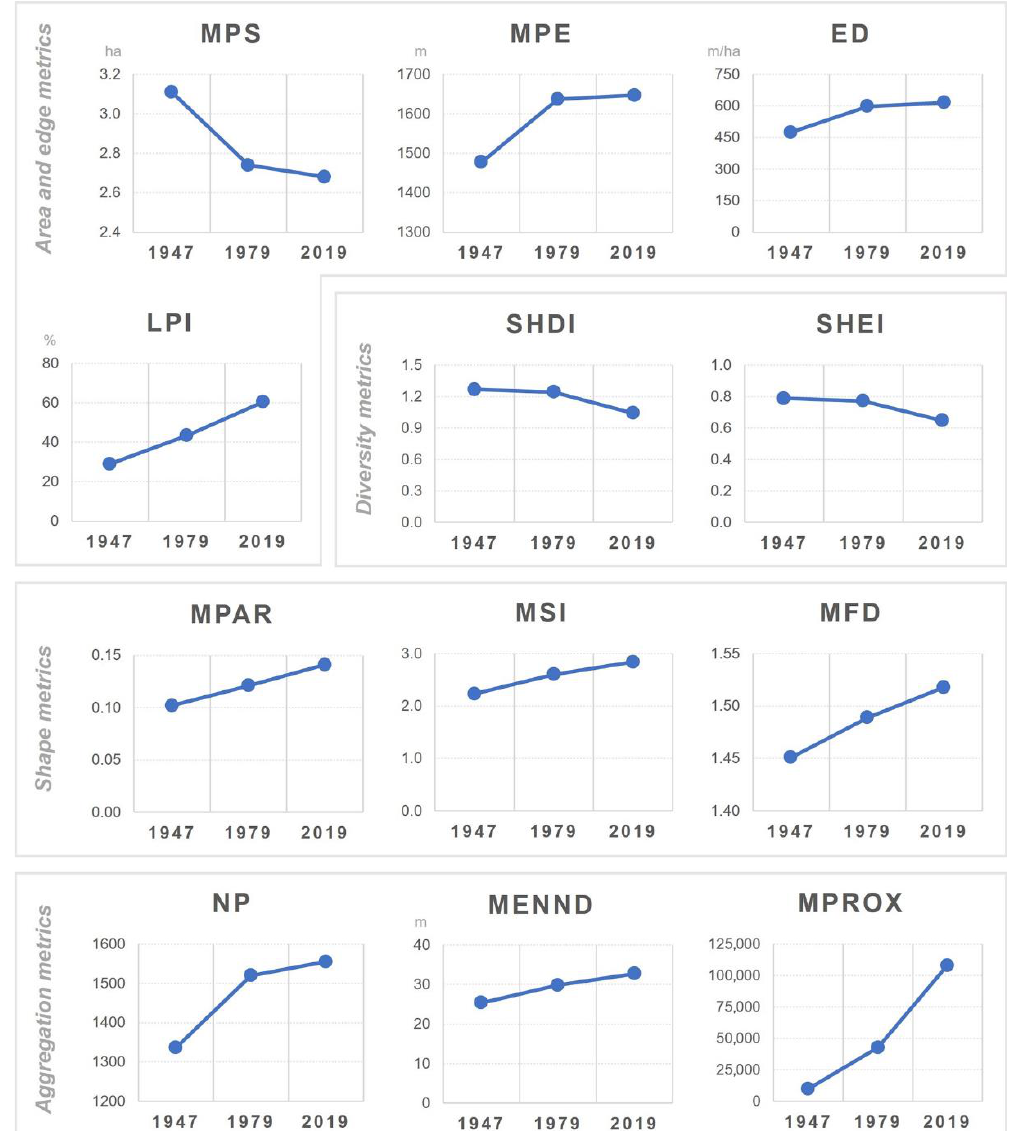
Figure 5. Evolution of spatial metrics at the landscape level, for the period 1947–1979–2019 (see Table A1 for detailed values). MPS: mean patch size; MPE: mean patch edge; ED: edge density; LPI: largest patch index; SHDI: Shannon’s diversity index; SHEI: Shannon’s evenness index; MPAR: mean perimeter–area ratio; MSI: mean shape index; MFD: mean fractal dimension; NP: number of patches; MENND: mean Euclidean nearest neighbour distance; MPROX: mean proximity index.